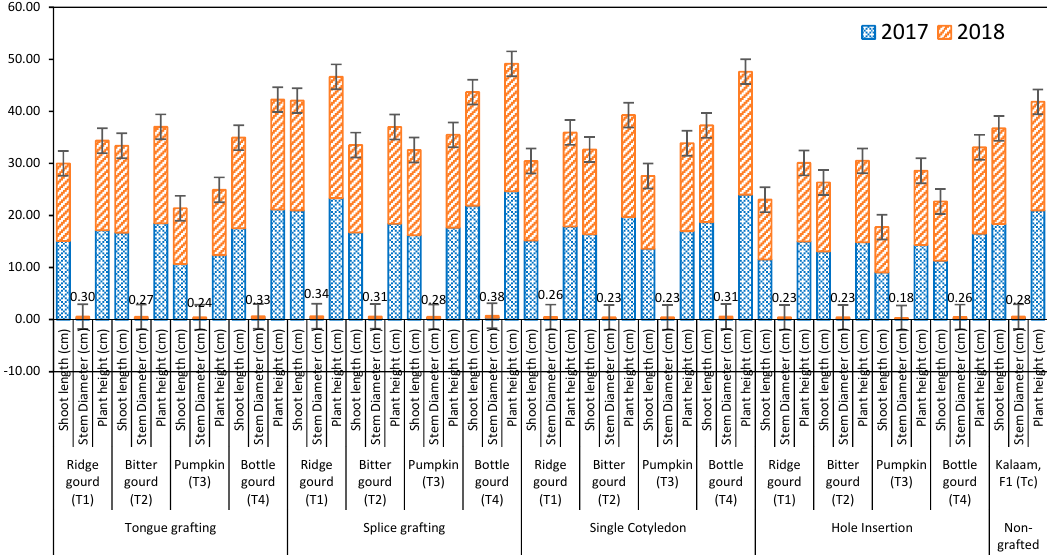
Figure 4. E ff ect of Scion / rootstocks combinations (grafting) on vegetative growth parameters of Figure 4. Effect of Scion/rootstocks combinations (grafting) on vegetative growth parameters of Cucumber fruit after 30 days during crop season 2017 and Cucumber fruit after 30 days during crop season 2017 and 2018.